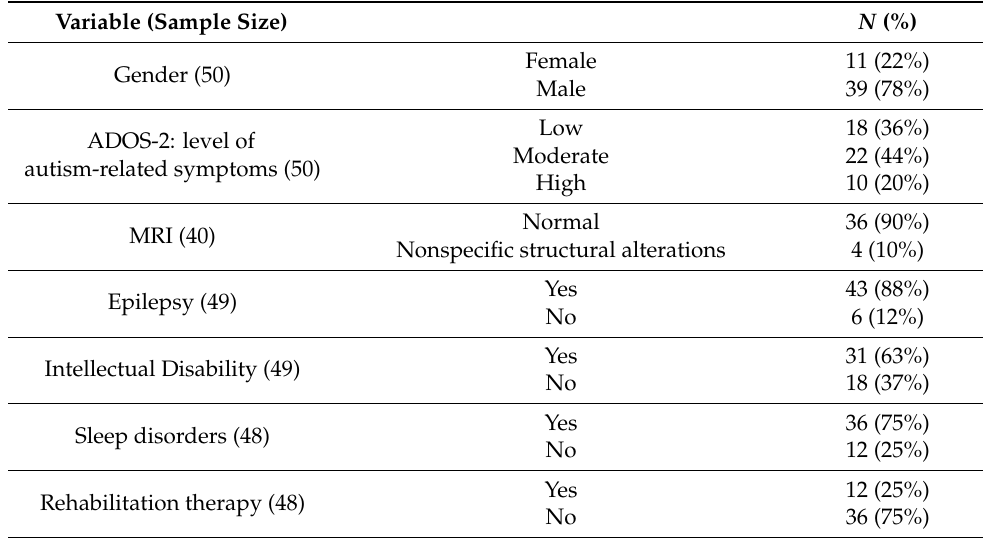
Table 1. Demographic and clinical–instrumental variables.